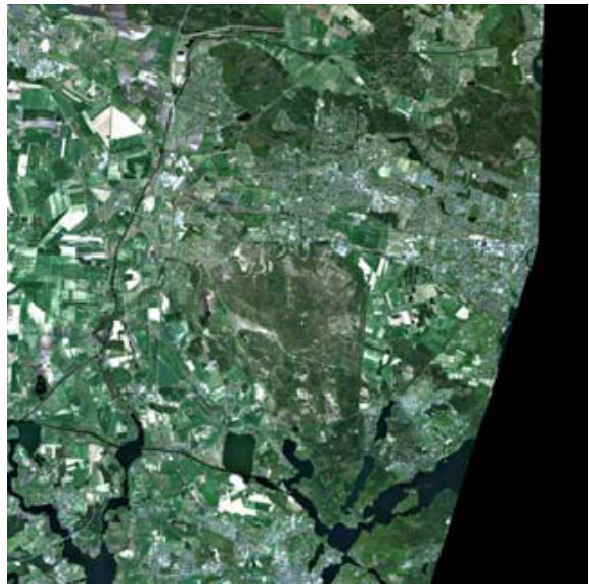
Figure 4. Example for processing RapidEye data Upper left: RGB composite of input image (top of atmosphere) Red circle marks the sunphotometer location. Upper right: RGB composite of corrected image (BOA) Lower left: haze/cloud/water mask Lower center: DDV classification map Lower right: AOT-image (Image over test site Potsdam, April 20,